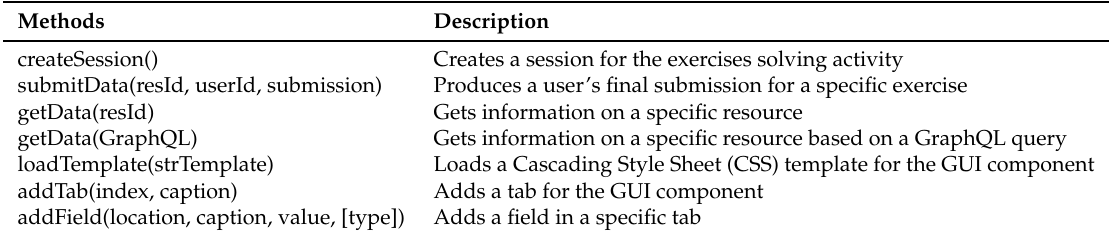
Table 2. PROud client library main